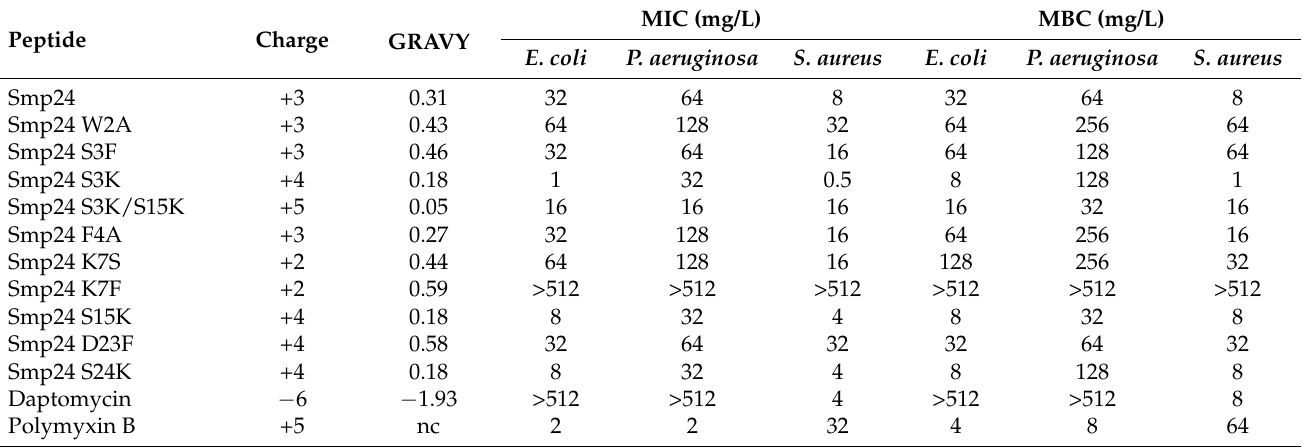
Table 2. MIC and MBC of Smp24 and modified peptides against a range of bacterial strains. Overall charge and hydrophobicity (grand average of hydropathicity index (GRAVY)) [16,21] are also shown. nc denotes not calculable due to the mixed population of the two separate